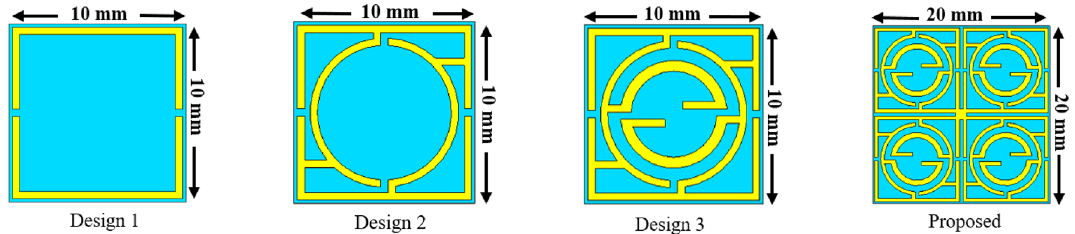
Figure 3. Design steps towards the proposed MTM unit cell (CST microwave studio suite 2019).